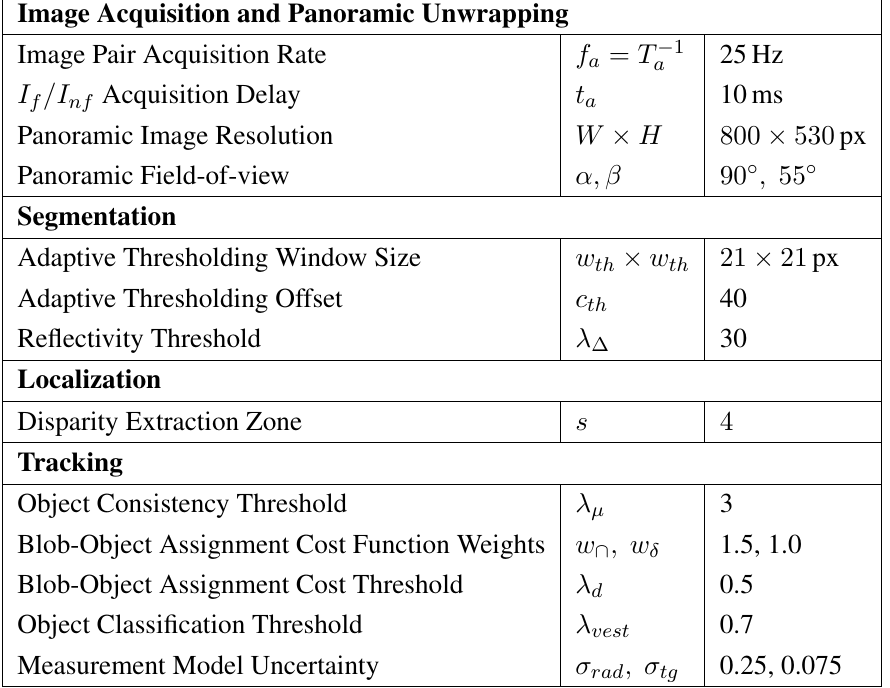
Table 1. Values of the system parameters used throughout the experimental